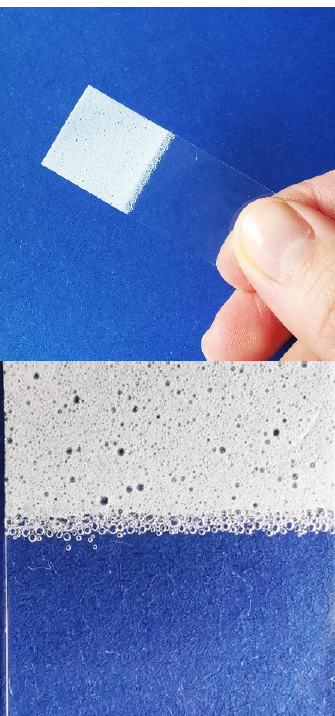
Figure 9. Applicator films with a ( a ) water-insoluble EC applicator and ( b ) water-soluble PVA ap- plicator. The pictures were taken in front of a blue background.